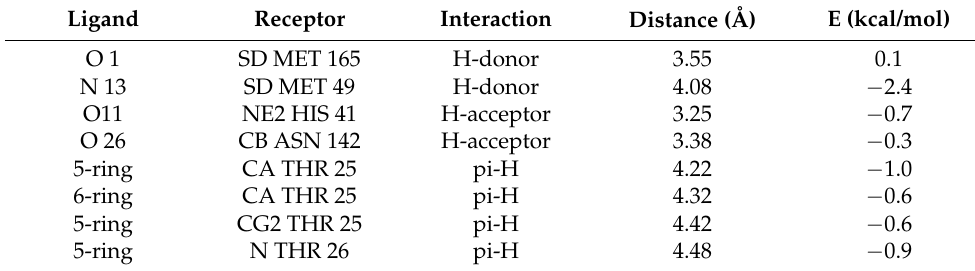
Table 4. Binding interactions of DNSPA with the amino acid residues of